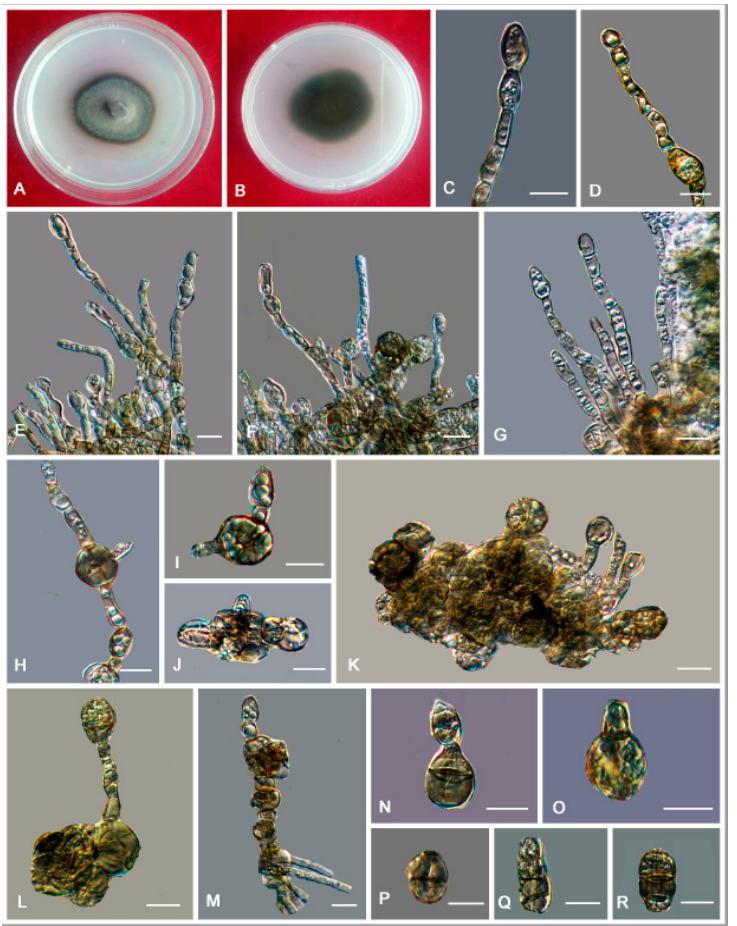
Figure 9. Bradymyces yunnanensis (CGMCC 3.17314). ( A , B ) Colony forward and reverse after 20 weeks on MEA. ( C – G ) Catenated, moniliform hyphae. ( H , I ) Swollen cells in the intercalary of hyphae. ( J – R )